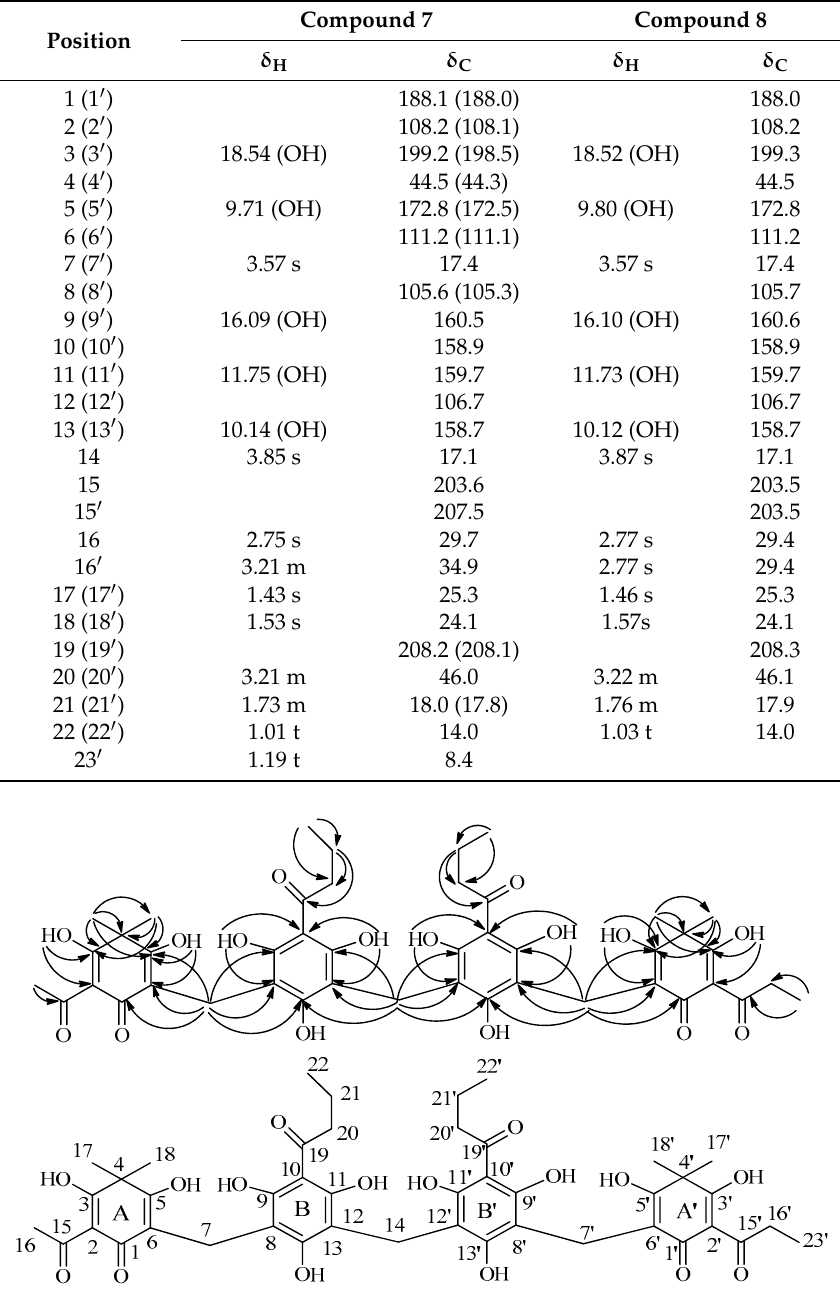
Table 2. 1 H- and 13 C-NMR spectroscopic data for compounds 7 and 8 in CDCl 3 .